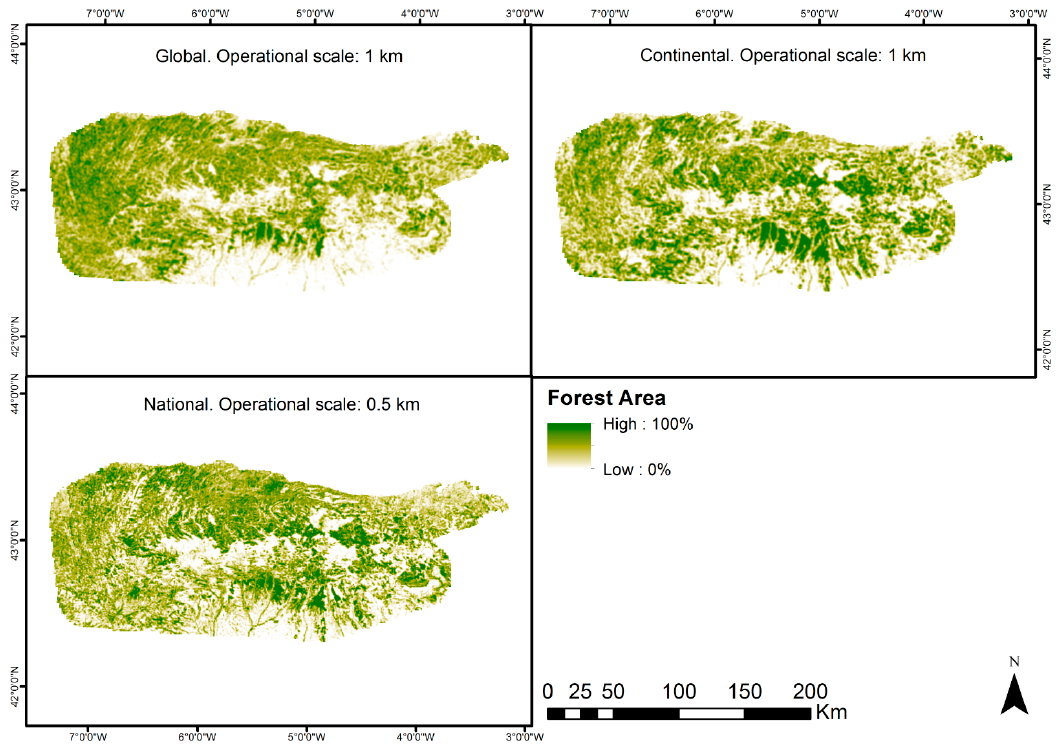
Figure A2. Operational scales of the forest area variable for the three datasets.